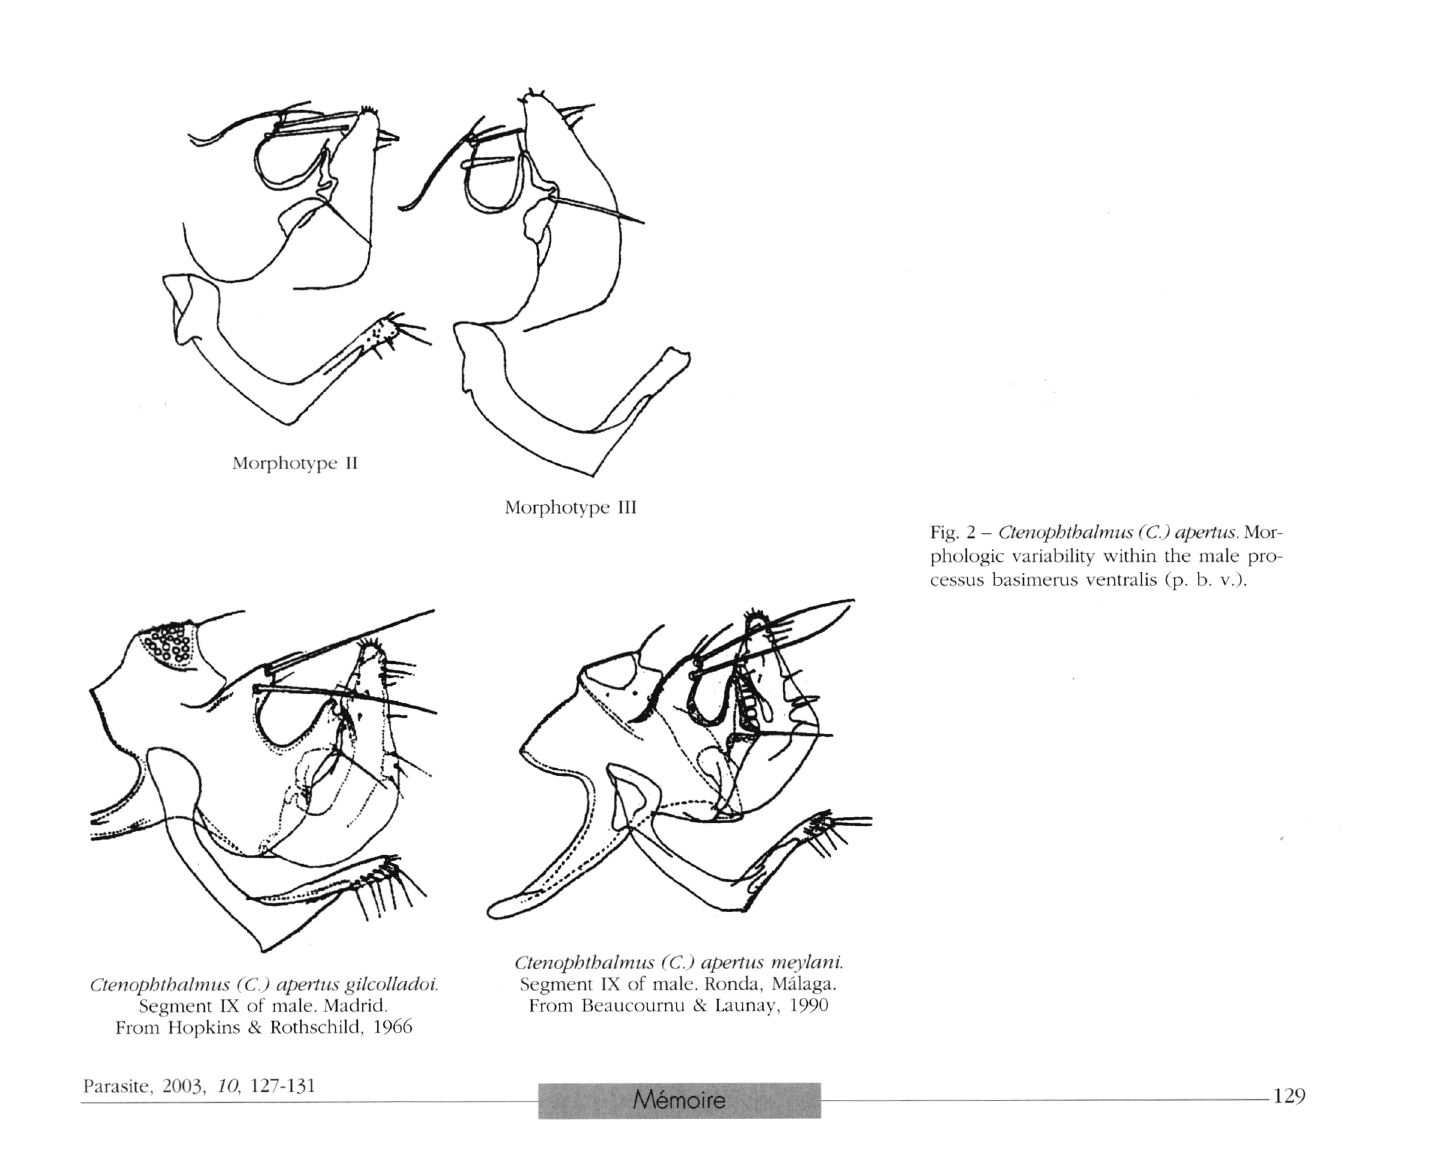
Fig. 2 - Ctenophthalmus (C.) apertus. Mor­ phologic variability within the male pro­ cessus basimerus ventralis (p. b.